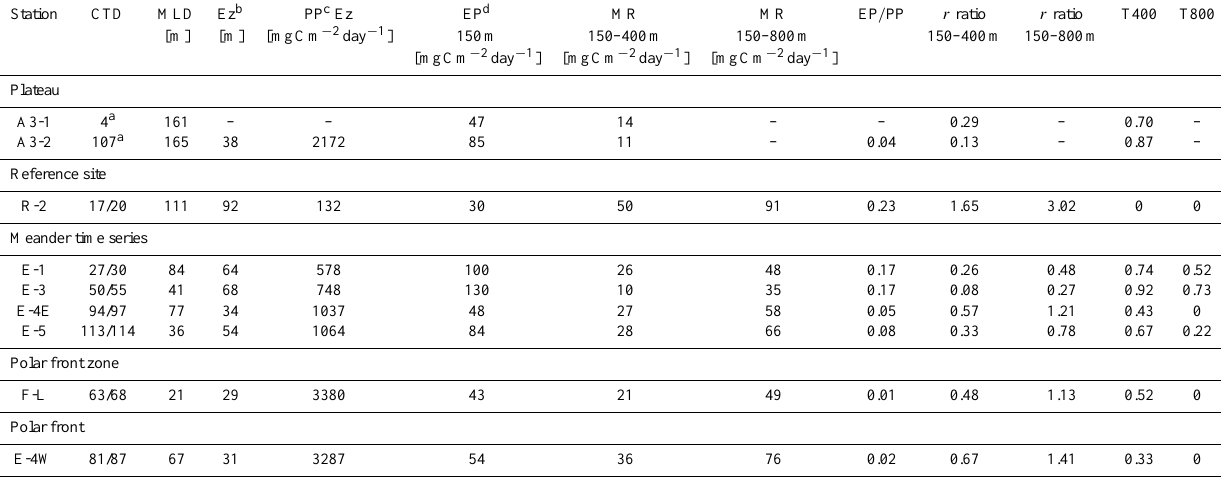
Table 2. Comparison of mesopelagic POC remineralization (MR) with primary production (PP) and export production (EP). All fluxes in mgCm − 2 day − 1 . r ratio is the ratio of Mr over EP. The C sequestration (or transfer) efficiency at 400 and 800m (T400, T800) is the fraction of C export (EP) at 150m exiting through the 400m (T400) or the 800m (T800) horizons. See text for further information on calculation.